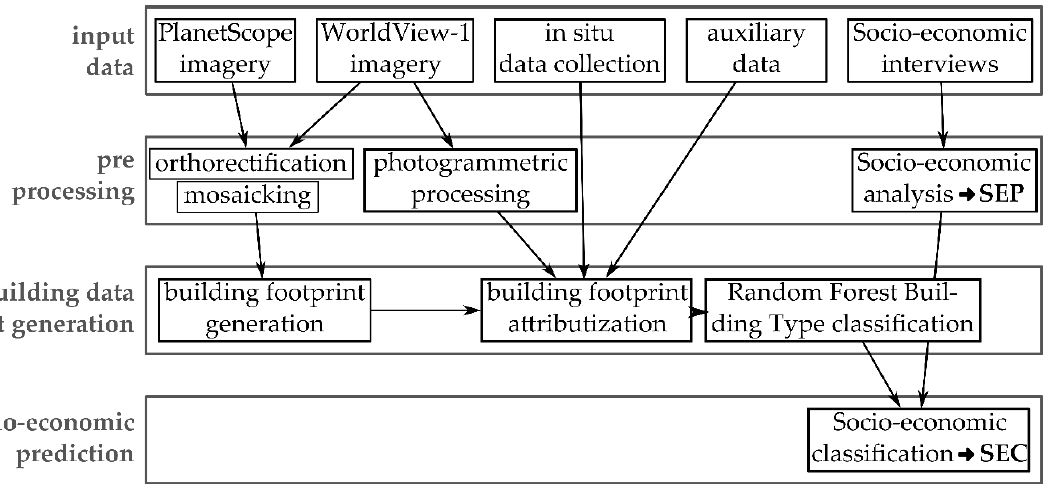
Figure 4. Schematic overview of the approach. Socio-economic analysis leads to the “socio-economic points” (SEP) ranking (see Sections 2.2.6. and 3.3.). The prediction of socio-economic status bases on points” (SEP) ranking (see Section 2.2.6. and Section 3.3.). The prediction of socio-economic building types via socio-economic classes (SEC) (see Sections 2.2.7. and 3.4.).